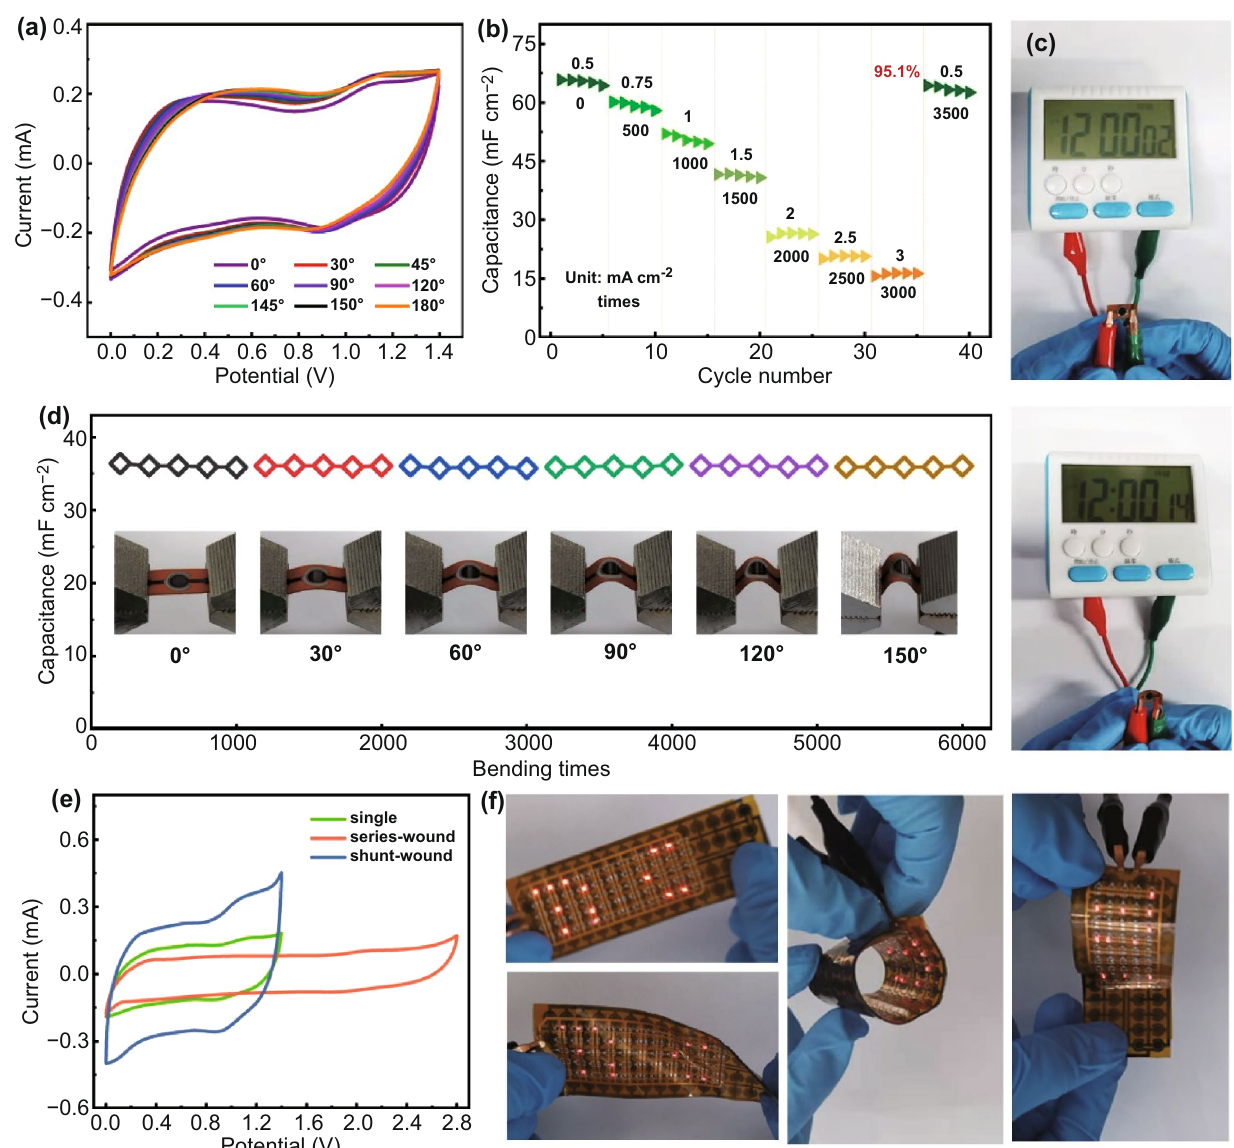
Fig. 5 Flexibility and rate stability of the fabricated Ti 3 C 2 T x -based Zn-ion MSC. a CV curves of the designed MSC under the different bending state. b Areal capacitance of the MSC at different current densities and bending times. c Photographs of the digital timer driven by the single Ti 3 C 2 T x -based Zn-ion MSC under a flat and bending state. d Areal capacitance change of the fabricated MSC under different bending states for several bending cycles. e CV curves of the as-prepared two MSCs in series and parallel. f Digital images of the Ti 3 C 2 T x -based Zn-ion MSC array powering a flexible LED array of the “TiC” logo under various types of deformations like twisting, crimping, and